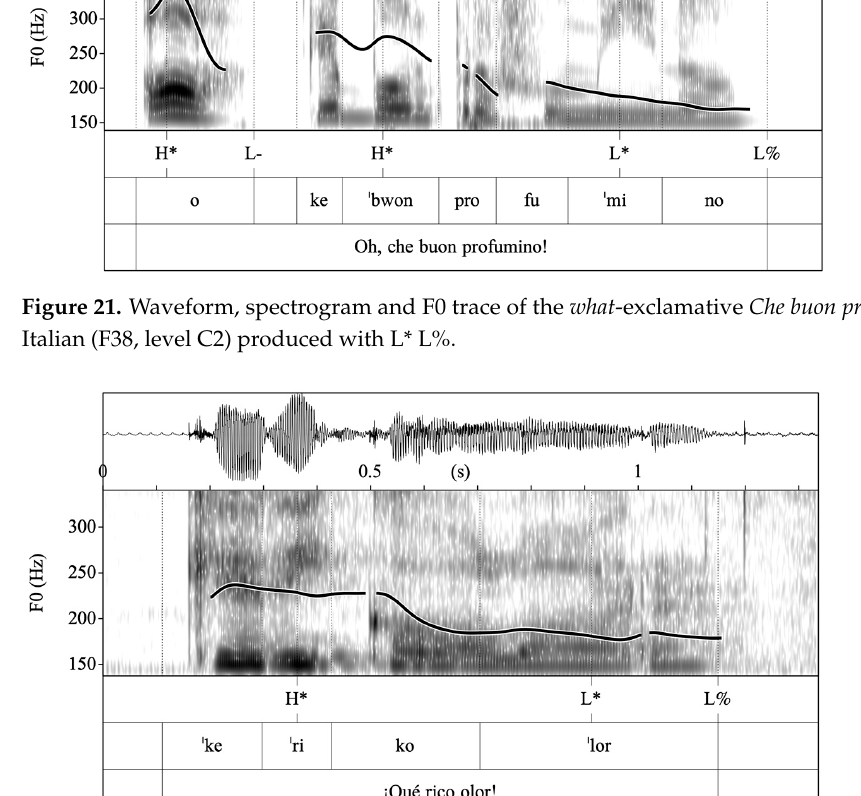
Figure 23. Waveform, spectrogram and F0 trace of the what -exclamative Ciao, Roberto! Che sorpresa! in L2 Italian (F35, level C1) produced with L* L%.